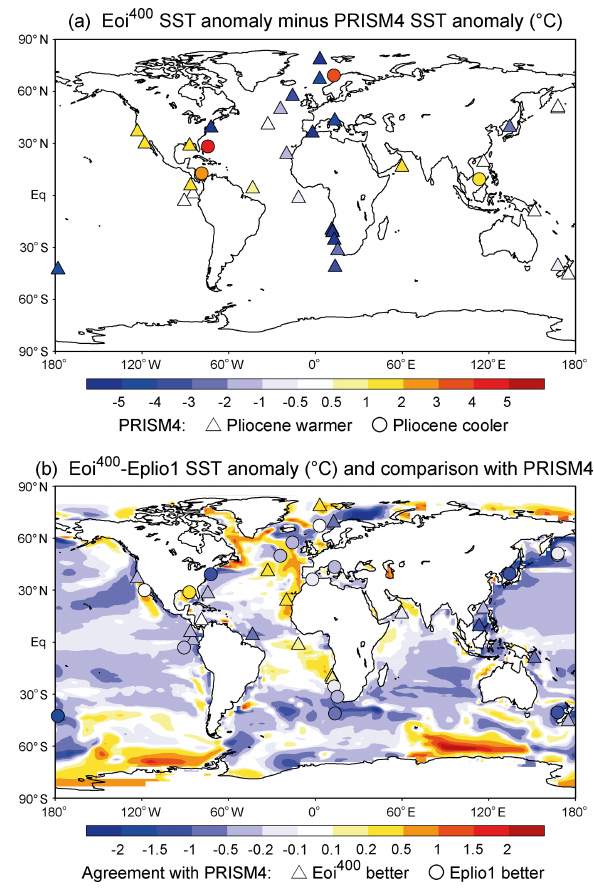
Figure 17. (a) Comparison of annual mean model SST anoma- lies and PRISM4 proxy data SST anomalies. Blue (red) indicates that model SST anomalies are smaller (greater) than those of proxy data. The shape of the symbols indicates whether proxy data sug- gest higher (triangle) SST in the Pliocene or lower (circle). (b) The difference between PlioMIP1 and PlioMIP2 SST. The shape of the symbols at PRISM4 locations indicates whether PlioMIP2 agrees better with proxy data (triangle) or whether PlioMIP1 agrees better